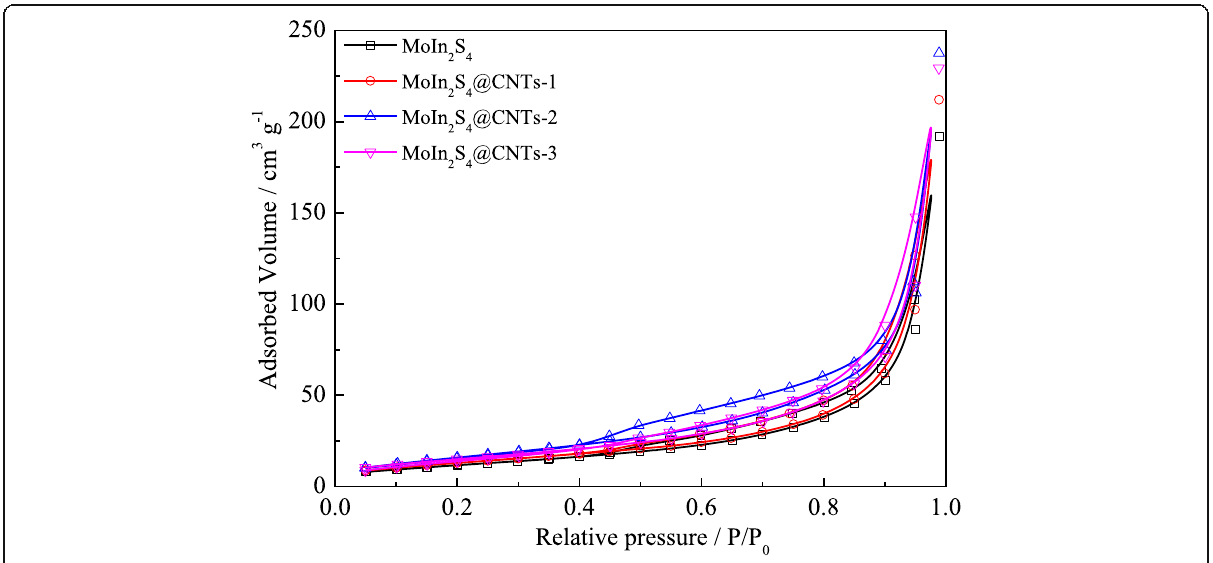
Fig. 4 N 2 absorption-desorption isotherms of various samples